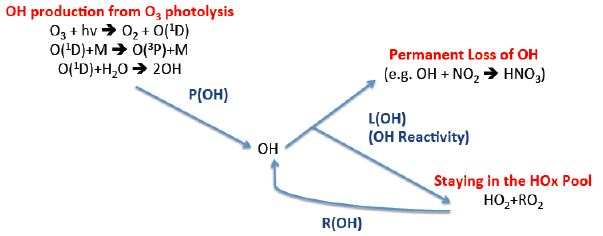
Figure 1. Steady-state calculation scheme used in this study.